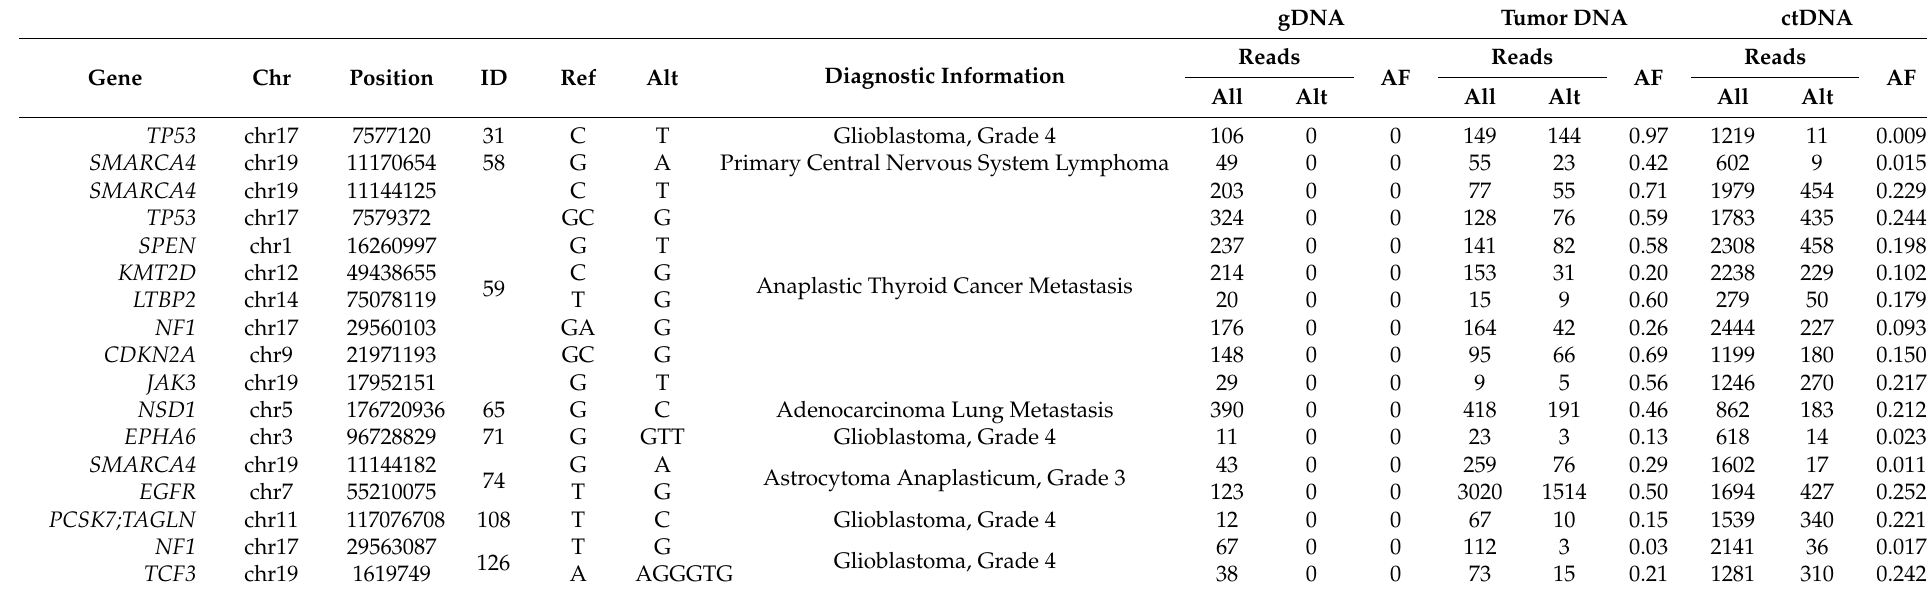
Table 1. Somatic variants detected in ccfDNA and in the tumor sample.